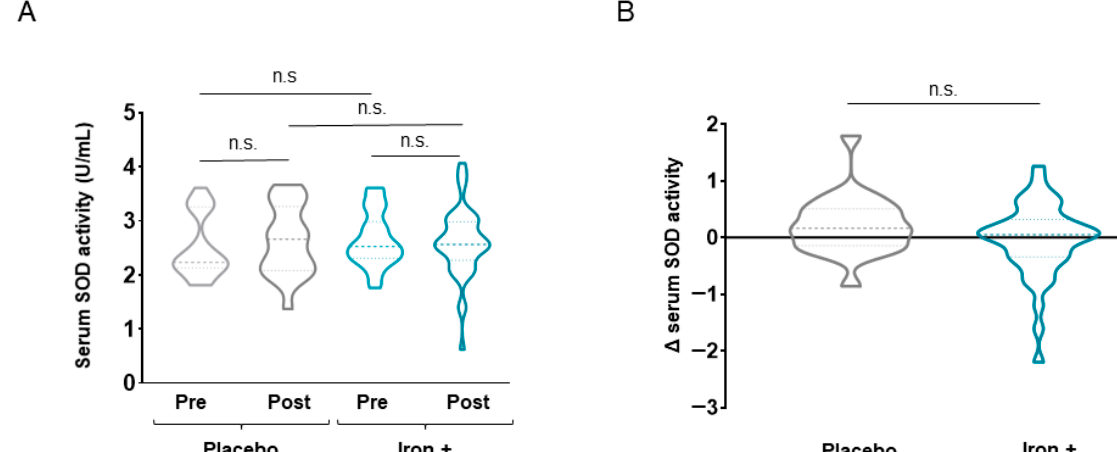
Figure 8. Violin plots of absolute SOD activity in serum of all COPD patient groups ( A ) and delta (post-pre) of serum SOD activity levels in placebo and iron-treated groups ( B ). The dashed line represents the median and the dotted lines the interquartile ranges. Statistical significance: n.s., no significance. Definition of abbreviations: SOD, superoxide dismutase.